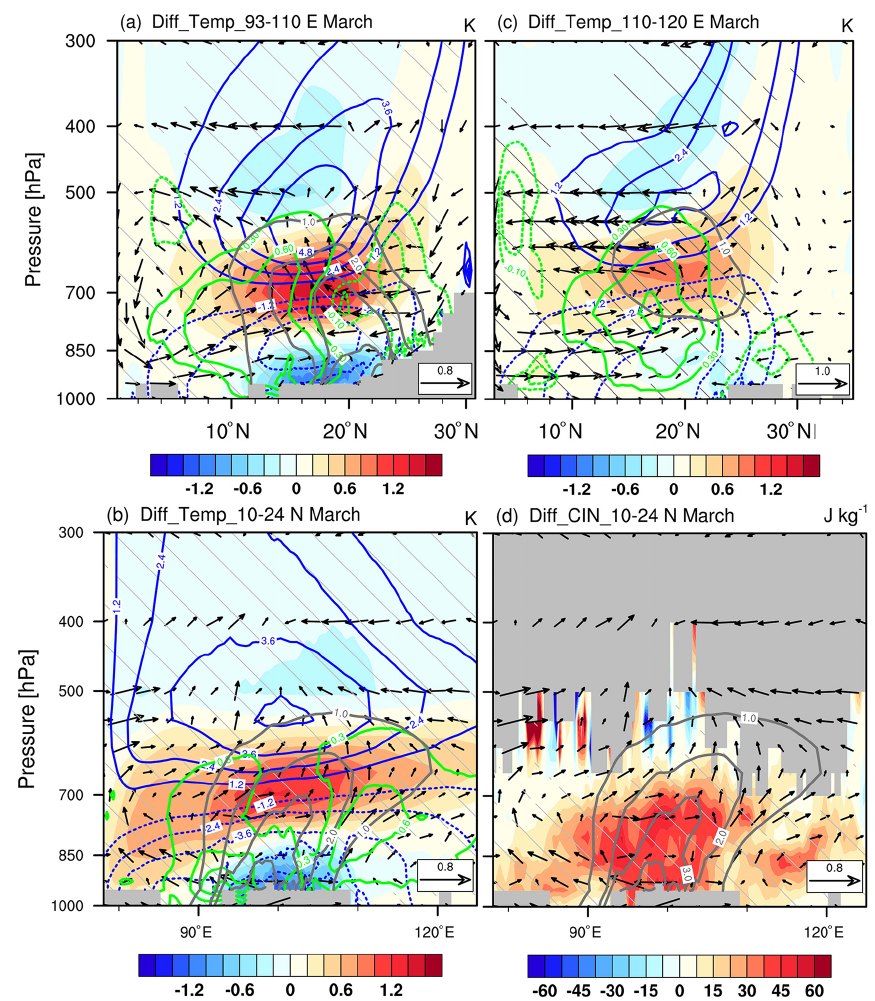
Figure 10. (a–c) Vertical cross sections of differences (CTRL minus BBER) in temperature (shading; K), geopotential height (blue contours with an interval of 1.2dagpm; the dashed contours are for negative values, and the zero contour is omitted for clarity), and water-vapor content (green contours with intervals of 0.3gkg − 1 for positive values and 0.1gkg − 1 for negative values, and the zero contour is omitted for clarity) averaged over (a) 93–110 ◦ E, (b) 10–24 ◦ N, and (c) 110–120 ◦ E in March 2010 together with (a, c) meridional or b zonal vertical velocity (vector; ms − 1 and 10 − 2 ms − 1 , respectively) and BC mass concentration (solid grey contours with an interval of 1.0µgm − 3 ). (d) Same as (b) but for convective inhibition (CIN; shading; Jkg − 1 ). Hatching and vectors denote the shaded field, and wind changes are statistically significant at the 95% confidence level, respectively, based on a Student’s t